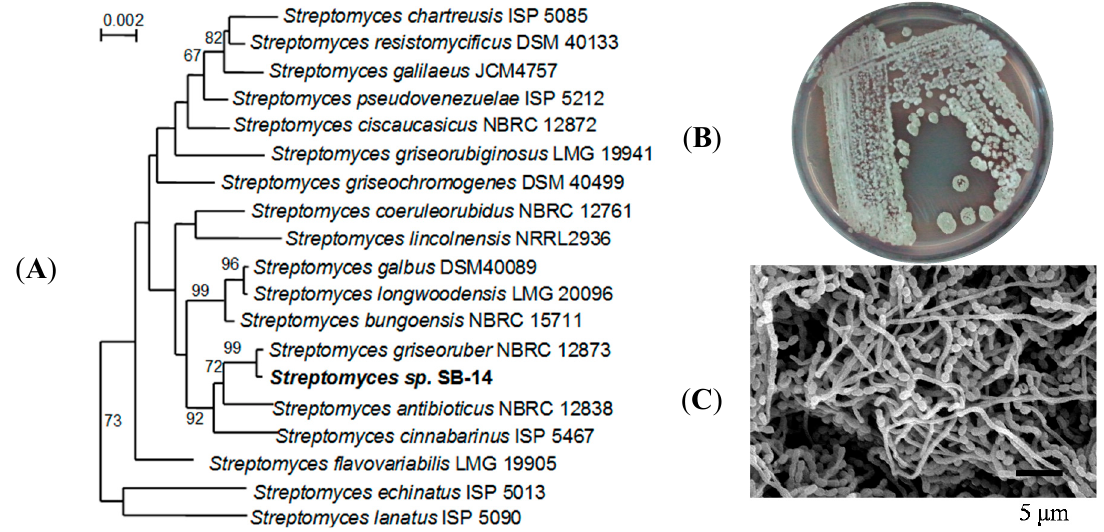
Figure 2. ( A ) Neighbor-joining phylogenetic tree based on 16S rRNA gene sequences showing the relationships between strain SB-14 and the type strains of recognized Streptomyces species. Numbers at branch points are bootstrap values (percentages of 1000 replications); only values > 50% are shown. Bar, 0.002 substitutions per nucleotide position. The ( B ) Streptomyces sp. Strain SB-14 screened ( C ) Scanning electron